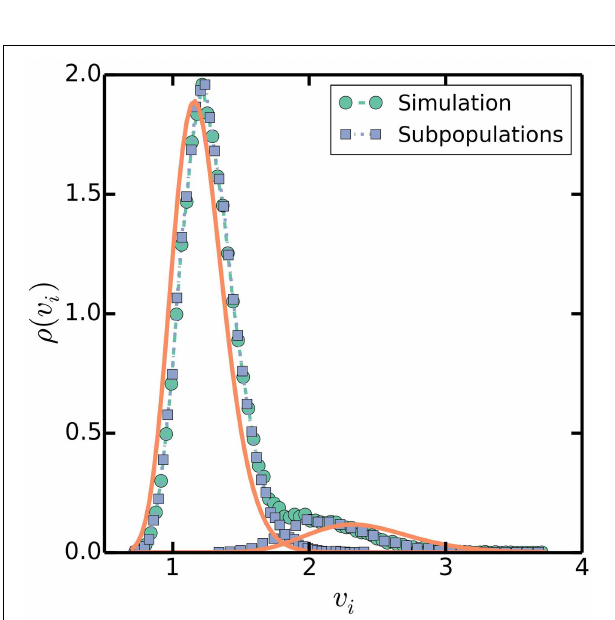
FIGURE 6 | Pearson (left) and Kendall (right) correlations between cell sizes at birth v b and cell size differences between birth and division 1 v against σ C + D /σ τ .